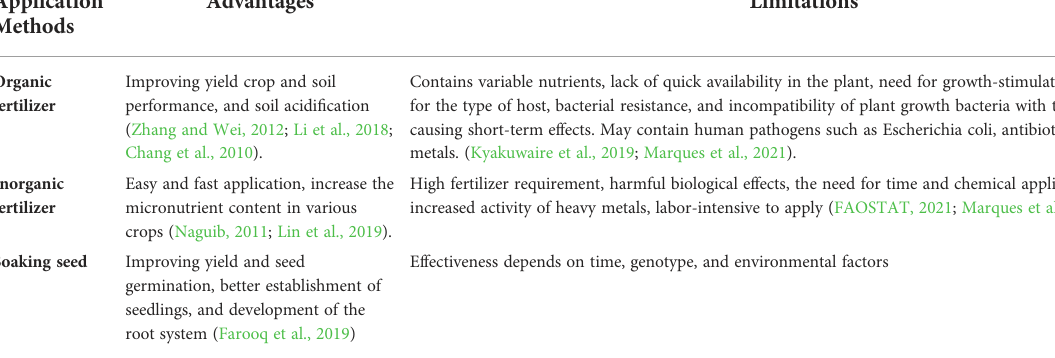
TABLE 1 Common methods of plant nutrition and